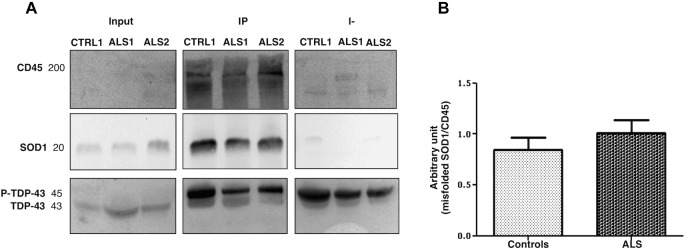
Misfolded SOD1 enrichment in LMVs (CD45+ MVs) from ALS patients and controls. CD45+ MVs of patients (ALS 1 and ALS 2) and of CTRLs (CTRL1) were enriched with misfolded SOD1. Misfolded SOD1 was only found in LMVs. The cropped blots are used in the figure and full length blots are presented in Supplementary Figure S2. The immunodepleted (I-) fraction, which include all CD45 negative MVs from other cell origin, showed no or very little level of misfolded SOD1. TDP-43 was transported in its phosphorylated form by MVs of the IP and immunodepleted (I-) (A). ALS 1 and ALS 2 are referred to two slow progressing patients. Input = MVs whole lysate-20% of the IP; IP = CD45 immunoprecipitated MVs (LMVs); I- = immunodepleted. (B) Densitometric analysis of misfolded SOD1, normalized to CD45 band, revealed slight increase of misfolded SOD1 in all ALS patients compared to controls (0.8431 ± 0.1236, CTRL n = 10; 1.008 ± 0.1274, ALS n = 18).